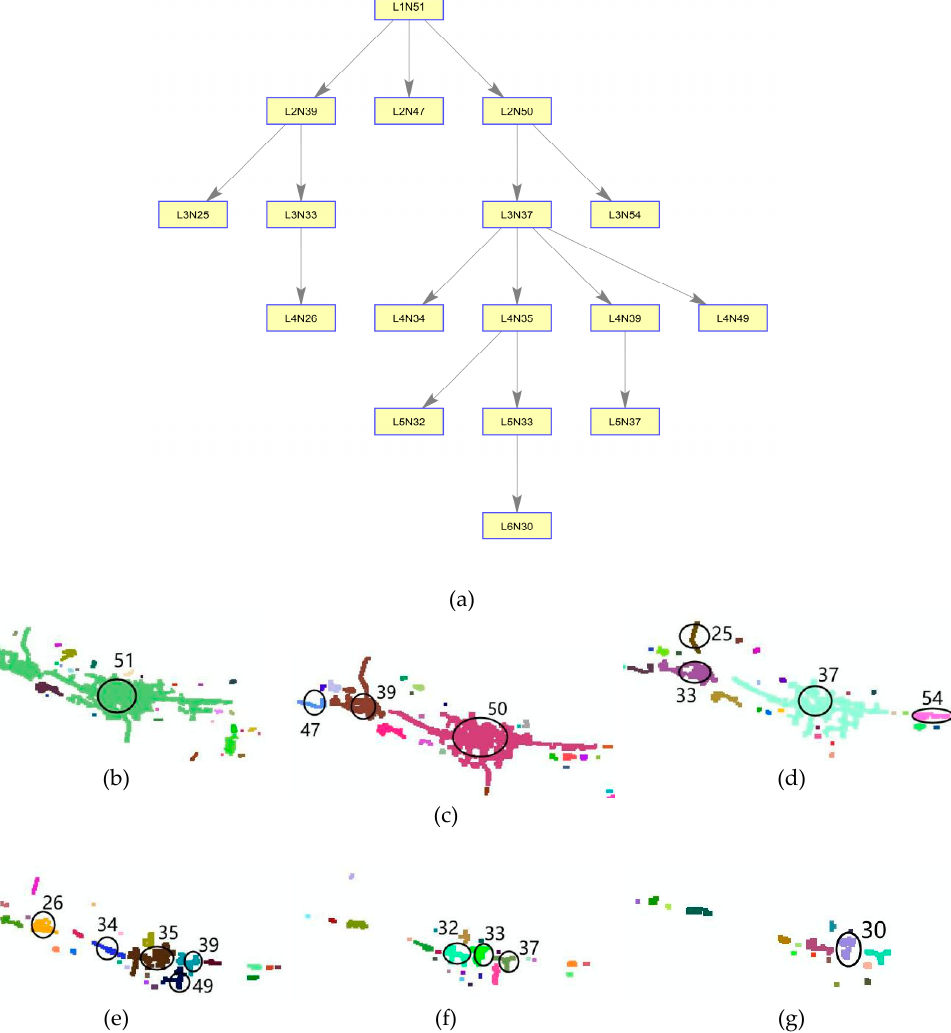
Figure 10. The central city tree structure of Pingdingshan: ( a ) the tree structure, ( b ) the distribution of connected regions corresponding to nodes at level 1, ( c ) the distribution of connected regions corresponding to nodes at level 2, ( d ) the distribution of connected regions corresponding to nodes at level 3, ( e ) the distribution of connected regions corresponding to nodes at level 4, ( f ) the distribution of connected regions corresponding to nodes at level 5 and ( g ) the distribution of connected regions corresponding to nodes at level